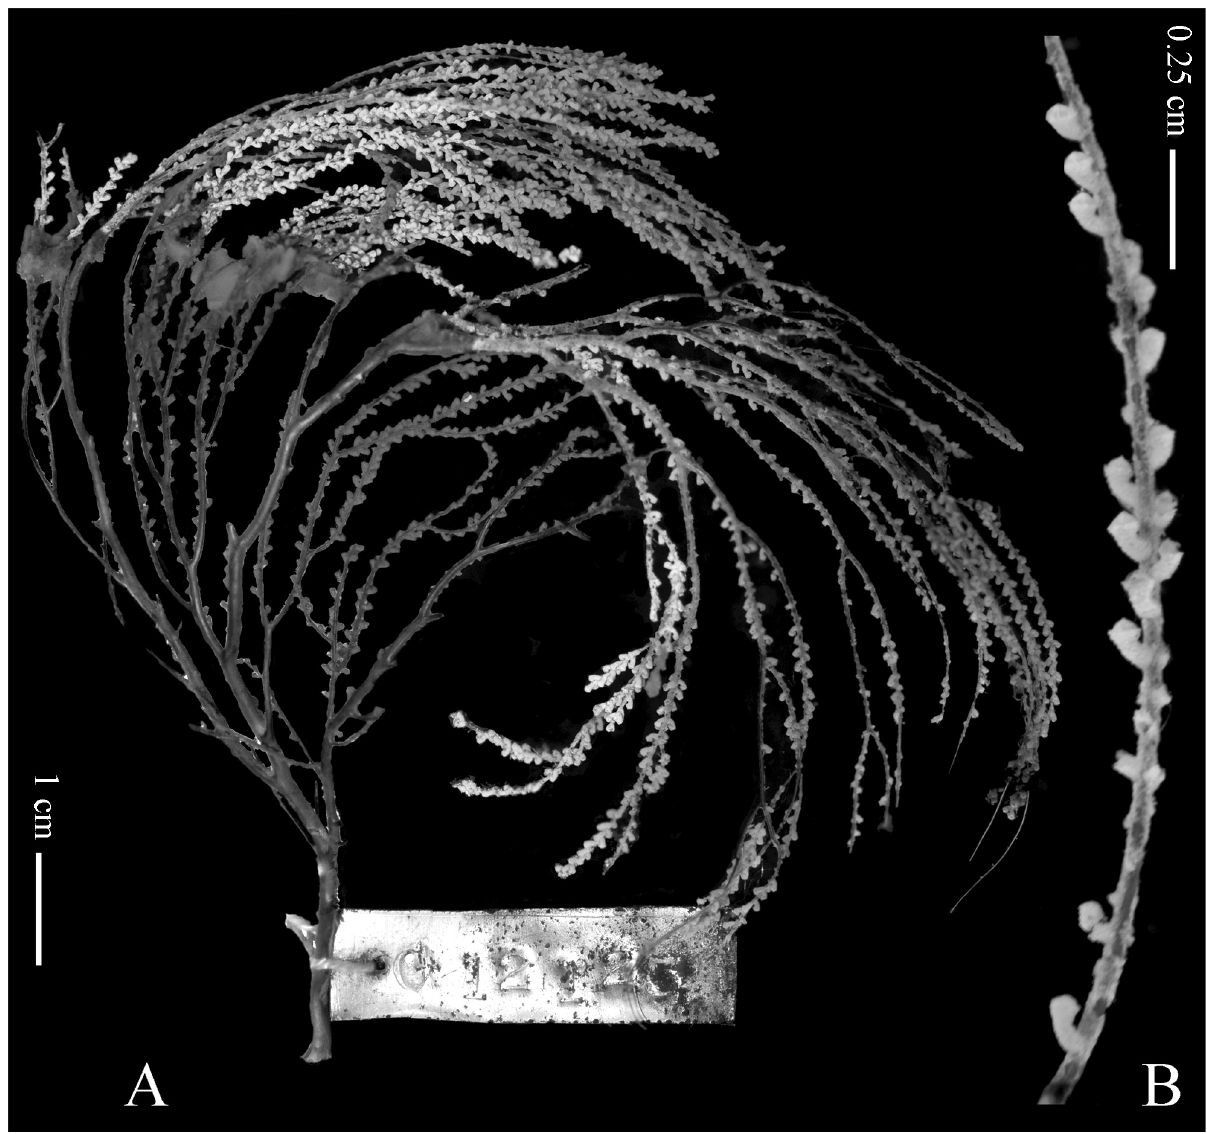
Fig . 23. – Primnocapsa plumacea (Thomson and Mackinnon, 1911) n. comb., holotype (AM G12123): A, whole colony; B, detail of